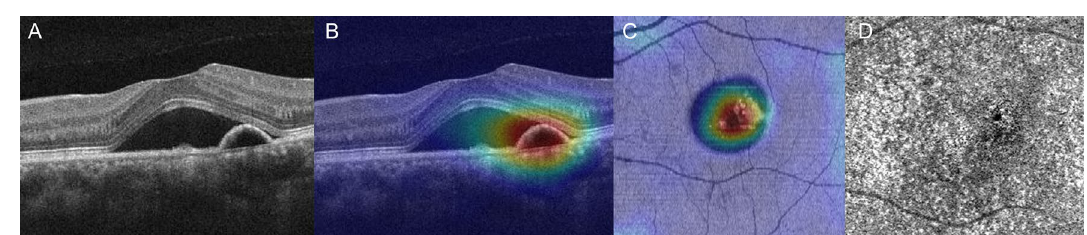
Figure 3. A representative case of persistent CSC with OCT angiography: the left eye of a 45-year-old male. ( A ) The OCT B-scan shows SRF with shallow irregular PED. ( B ) The heatmap overlying the OCT B-scan highlights important areas for use of DL in determining the prognosis of this case as persistent CSC. ( C ) A heatmap overlying the OCT en face image of the ellipsoid zone layer highlights the important areas. ( D ) OCT angiography does not reveal any choroidal